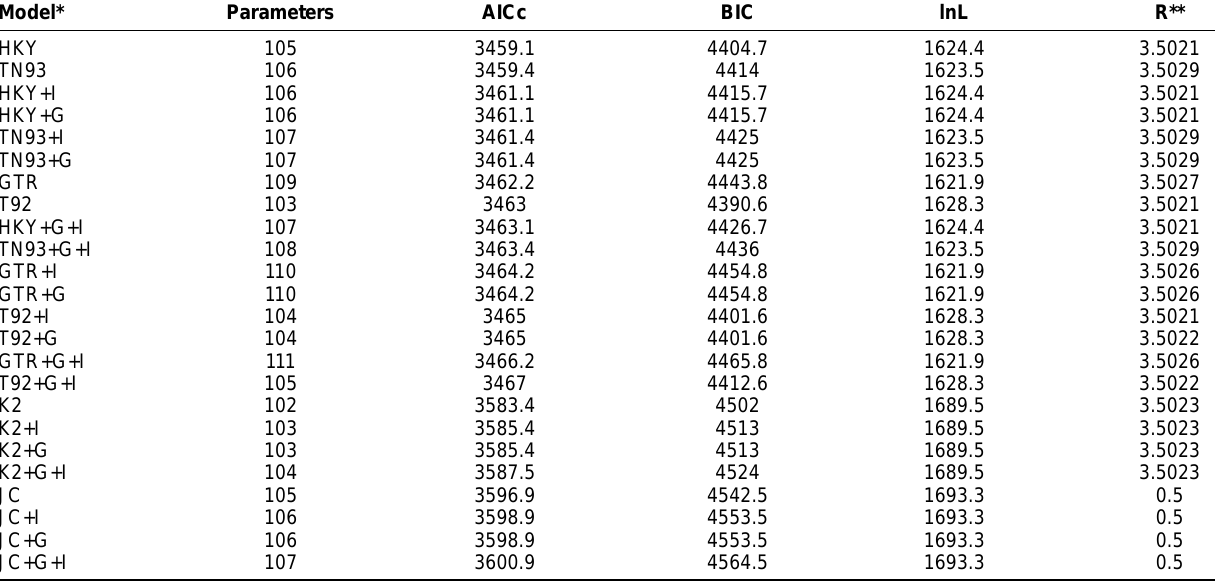
Table-3. AICc scores (Akaike Information Criterion, corrected), BIC value (Bayesian Information Criterion), Maximum Likelihood value ( lnL ) and Transition/Transversion bias (R) using 24 different nucleotide substitution models Model*